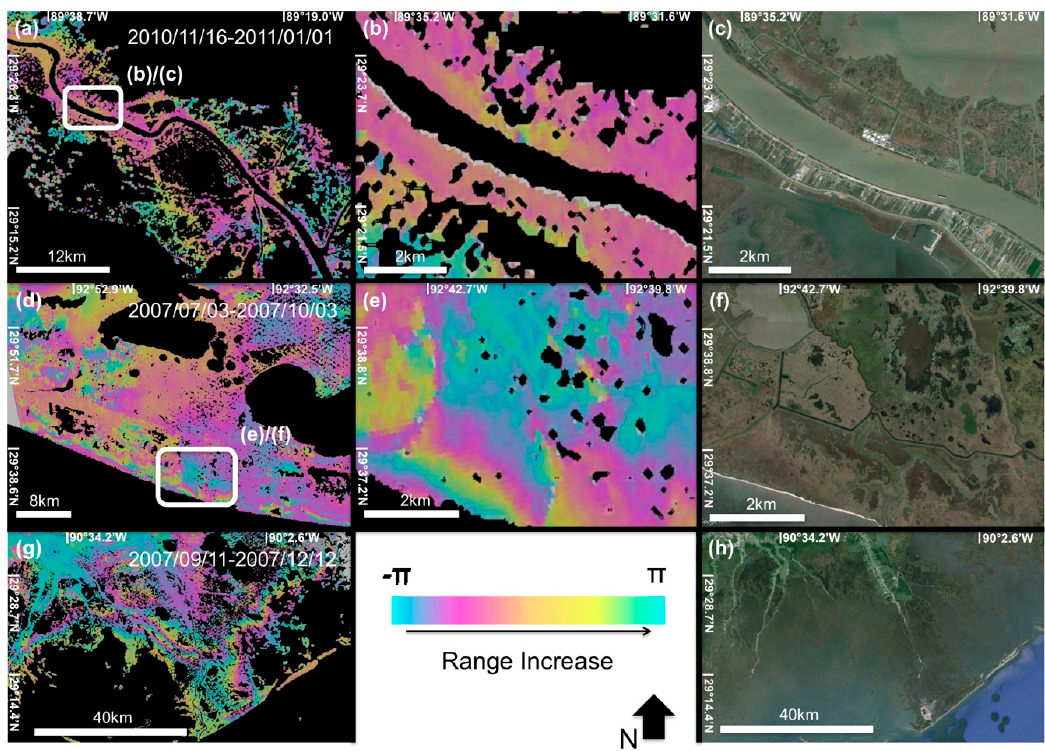
Figure 5. ( a ) ALOS interferograms of the Mississippi Delta showing phase change due to water level changes, spanning 46 days between acquisitions (16 November 2010–1 January 2011); ( b ) Zoom in area showing phase change due to tide inundation disruption caused by the presence of levees along the river; ( c ) Google earth image of the same study area; ( d ) ALOS interferogram of the central Chenier Plain showing phase changes due to water level changes, spanning 92 days (3 July 2007–3 October 2007); ( e ) Elongated fringe patterns sub-parallel to the coastline coinciding with man-made canals; ( f ) Google Earth image of the same study area; ( g ) ALOS interferogram of the west of the Mississippi River delta, spanning 92-day period (11 September 2007–12 December 2007). The interferogram shows fringe patterns due to tidal induced water level changes; ( h ) Google earth image of the same study area.